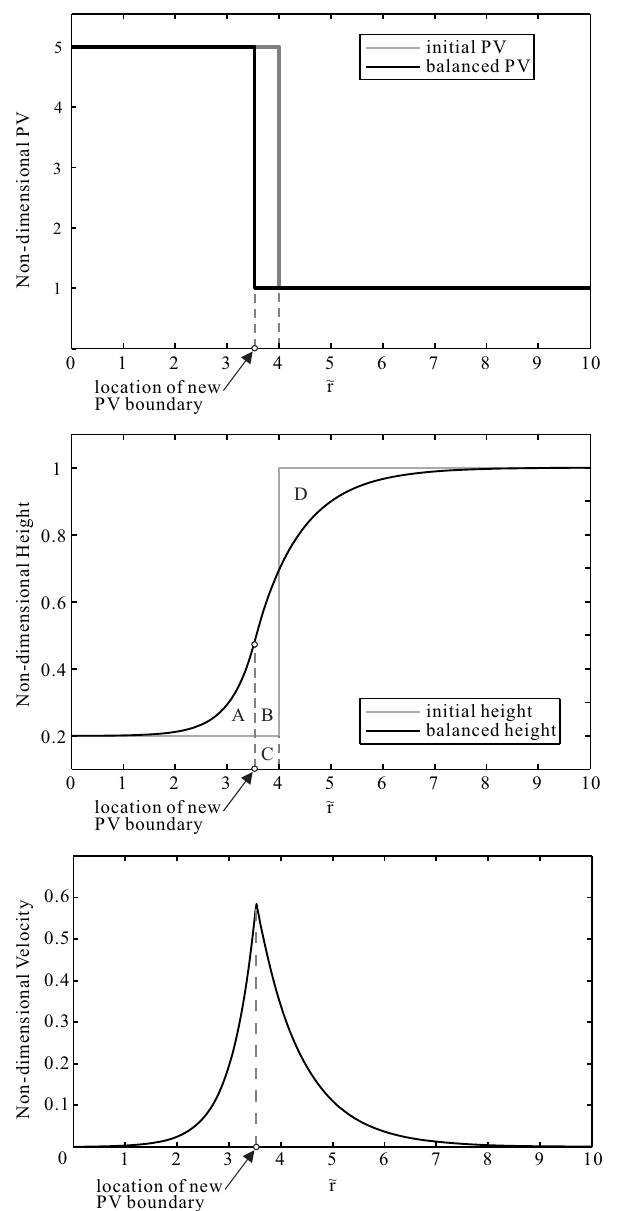
Figure 1. Non-dimensional solution of PV, height and tangential velocity with a 1 /L d = 4 and h (cid:48) o /H o = 0 . 8 in the geostrophically balanced shallow-water model.